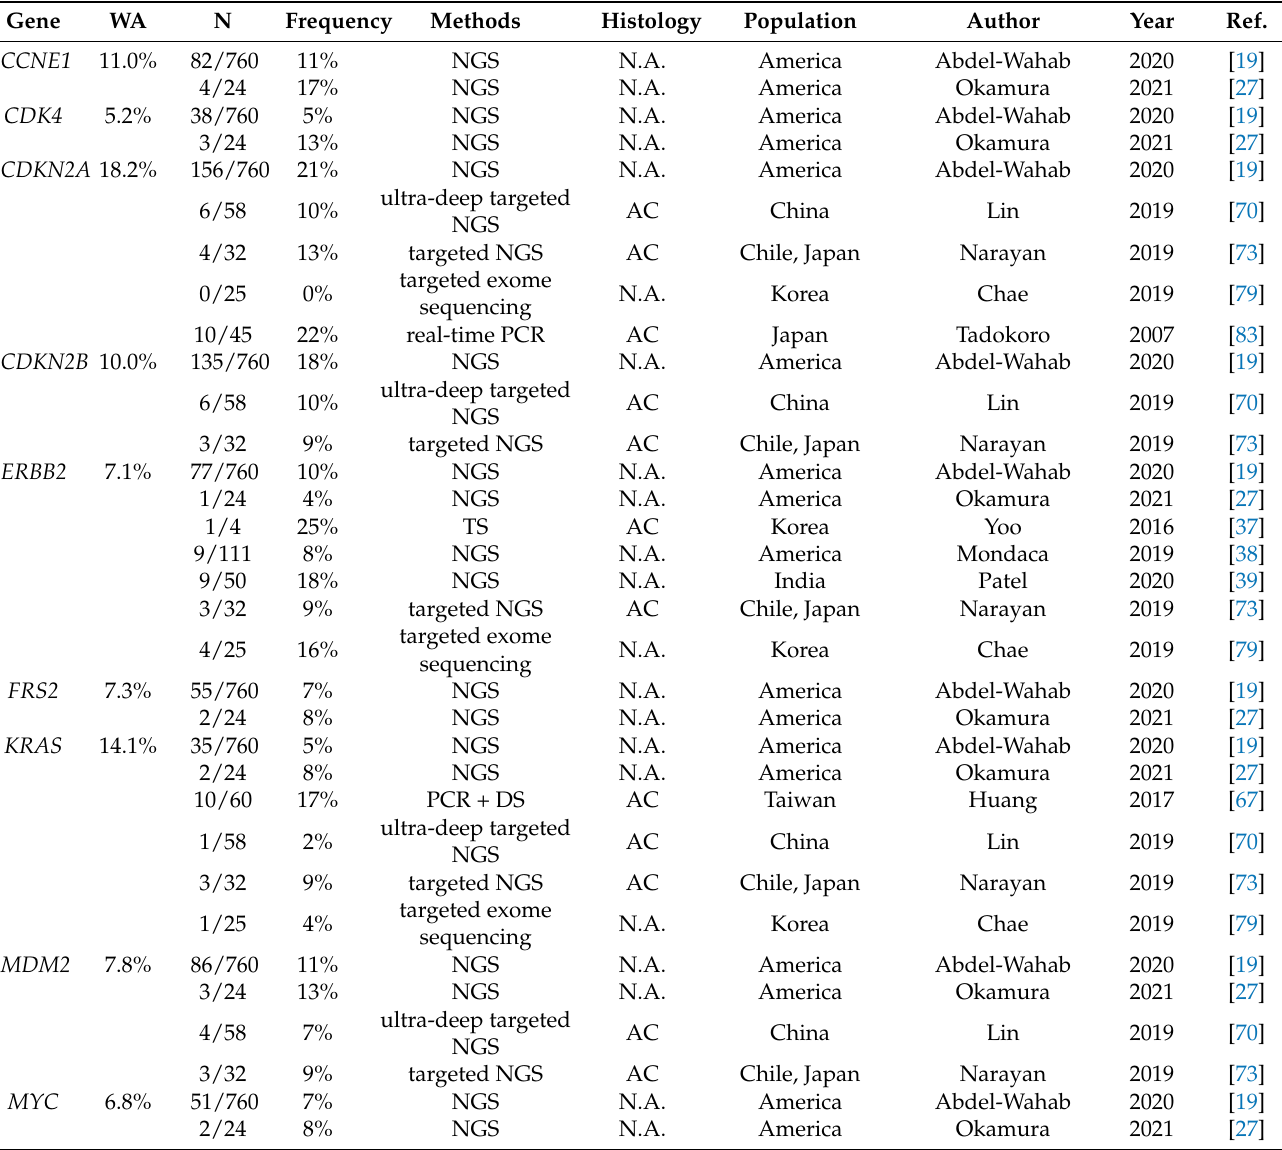
Table 1. Copy number aberrations in gallbladder cancer.